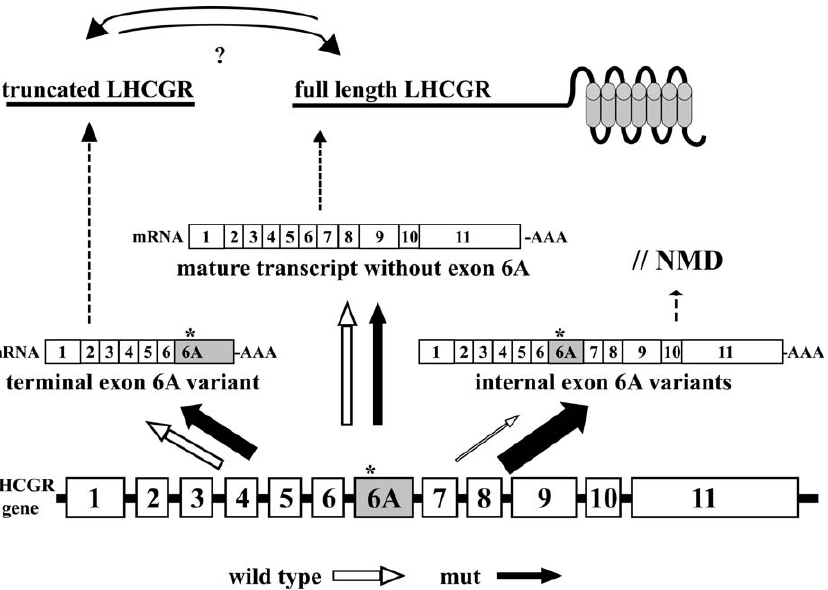
Figure 8. Transcriptional Network of the LHCGR Gene Hypothetical model of the transcriptional network of the LHCGR gene including the novel exon 6A in the wild type (hollow arrows) or mutated (filled arrows) forms. The primary transcript of the LHCGR gene includes exon 6A, which can then be skipped in the mature mRNA giving rise to the full-length LHCGR protein, or is spliced into the terminal or internal exon 6A variants. Since exon 6A contains a stop codon (asterisk), the terminal variant may be translated into a truncated LHCGR protein, which remains mainly trapped within the cell and could hypothetically interact with the mature, full-length protein. Conversely, the stop codon in the internal 6A variants is recognized by the NMD pathway, which actively eliminates these transcripts. Under physiological conditions, both the mature transcript without exon 6A and the terminal 6A variant are present in roughly equal amounts in cells normally expressing the LHCGR (hollow arrows of equal width). In mutation(s) of exon 6A, the NMD surveillance mechanism is probably inadequate to eliminate the internal exon 6 variants, which accumulate in the cell and alter the relative abundance of the various transcripts, possibly resulting in an excessive increase of truncated LHCGR protein, incompatible with ‘‘ normal ’’ receptor function. Figure S1. Exon 6A: Sequence Comparison, Phylogeny, and Genomic Organization (A) Upper part: Genomic and cDNA nucleotide sequence comparison of exon 6A from human ( Homo sapiens ), chimpanzee ( Pan troglodytes ), cynomolgus monkey ( Macaca fascicularis ), marmoset ( Callithrix jacchus ), and lemur ( Eulemur coronatus ). Identical nucleotides are indicated by an asterisk. Sequences encompassing internal exon 6A are indicated by the grey line, while terminal exon 6A is indicated by a black line. Typical exon elements are given in bold italics or are boxed (poly[A] signal). Lower part: Comparison of the deduced amino acid sequence of exon 6A. (B) Evolutionary pedigree of primate lineage evolution after Singer et al. (2004). The approximate time of DNA insertion is indicated by the arrows. Time scale in million of years (mya). (C)Revisedorganizationofthegenomicregionbetweenexon6and7of the human, cynomolgus monkey, and mouse LHCGR gene. The exonic size is given above and the intronic size below the genomic elements. Found at doi:10.1371/journal.pmed.0050088.sg001 (4.6 MB PDF). Figure S2. Revised Complete Genomic Organization of the Human LHCGR Gene Now Consisting of 12 Exons Exon sizes are given above the boxes, intron sizes below. Found at doi:10.1371/journal.pmed.0050088.sg002 (9 KB PDF). Figure S3. Immunofluorescence Localization of HA-Tagged LHCGR Proteins in Transiently Transfected COS7 Cells (A) HA-tagged, wild-type terminal exon 6A LHCGR. (B) HA-tagged, A557C terminal exon 6A LHCGR. (C) Full-length HA-tagged LHCGR protein. Both truncated LHCGR variants, wild-type and mutated, show a